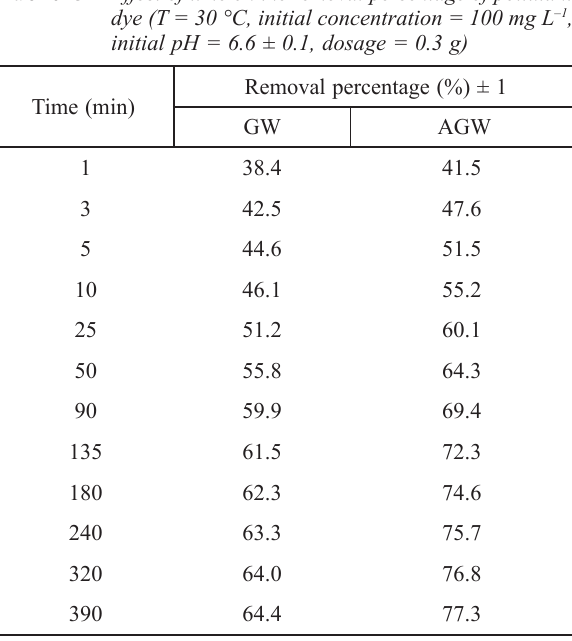
Table 4 – Regression results of kinetic parameters